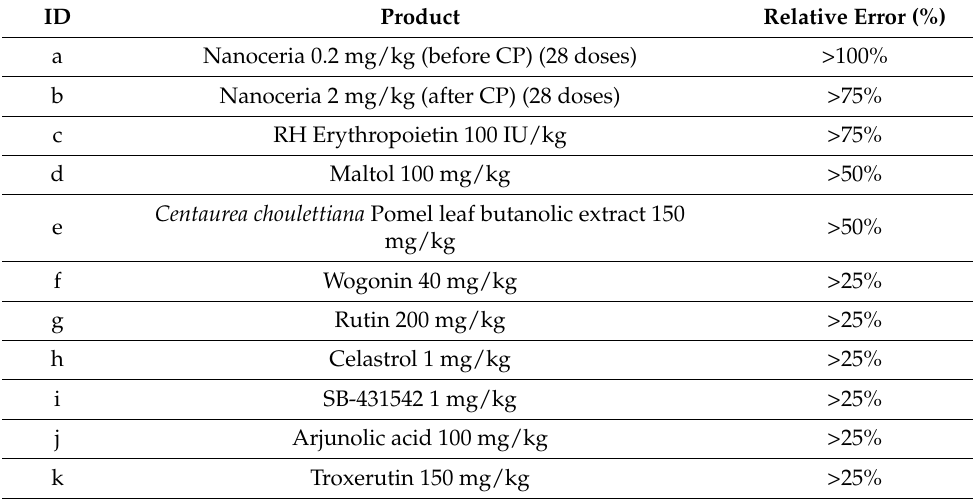
Figure 3. RANSAC linear regression and 25, 50, 75, and 100% relative error areas. Products over the model afford a greater nephroprotection than expected from their antioxidant effect. Products within these areas are identified and shown in Table 2. Letters (a through v) identify individual products, as listed in Table 2. Table 2. Products providing higher nephroprotection than expected from their antioxidant effect, according to their relative position with respect to the RANSAC linear regression